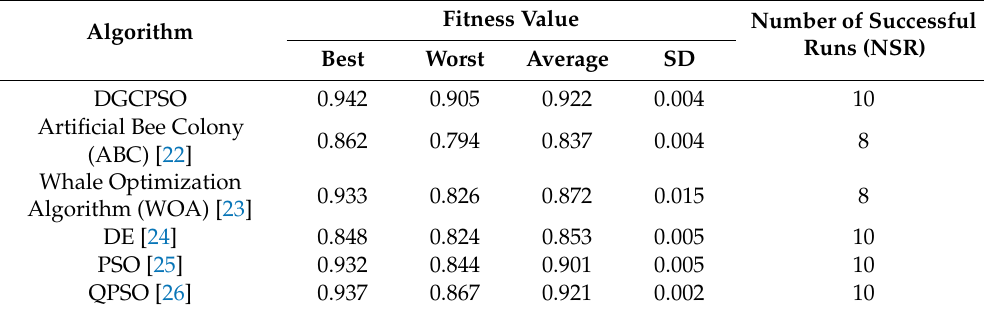
Table 6. E ffi ciency of di ff erence algorithms in the training setting.